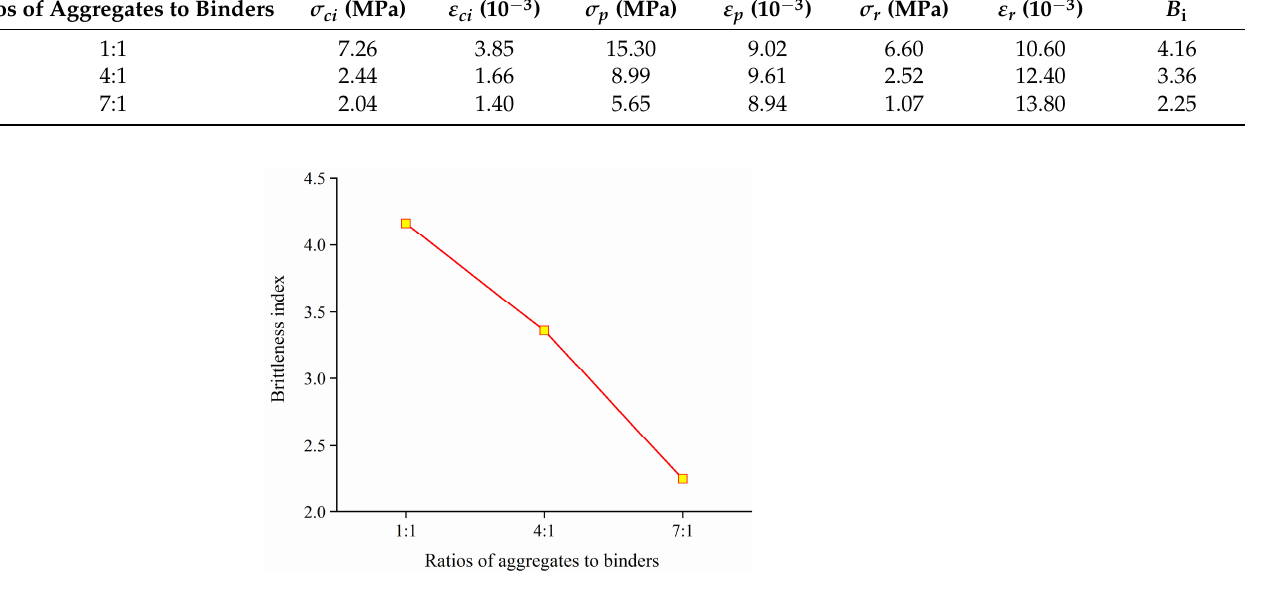
Figure 7. Relationship between the brittleness index ( B i ) and the ratios of the aggregates to binders.